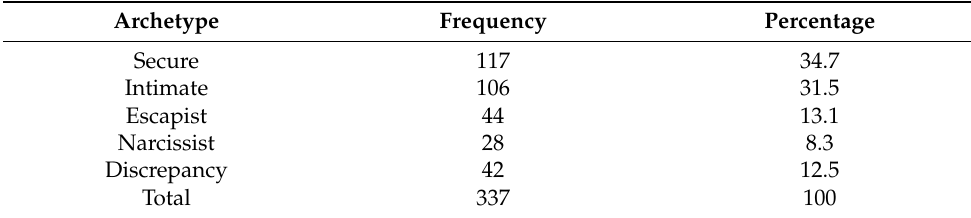
Table 5. Sample composition by archetypes.